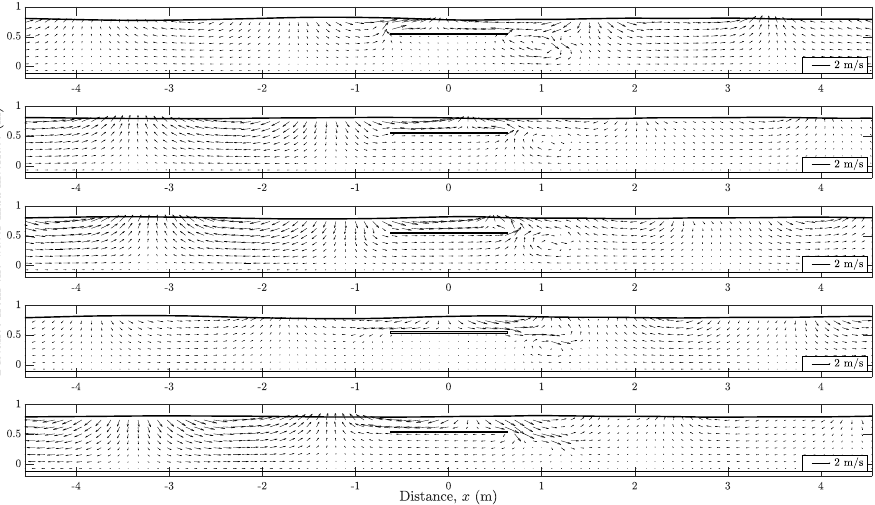
Figure 21. Snapshots of velocity field due to a submerged obstacle on a muddy bed with d m = 3 δ m . Top to bottom: t / T = 1 model